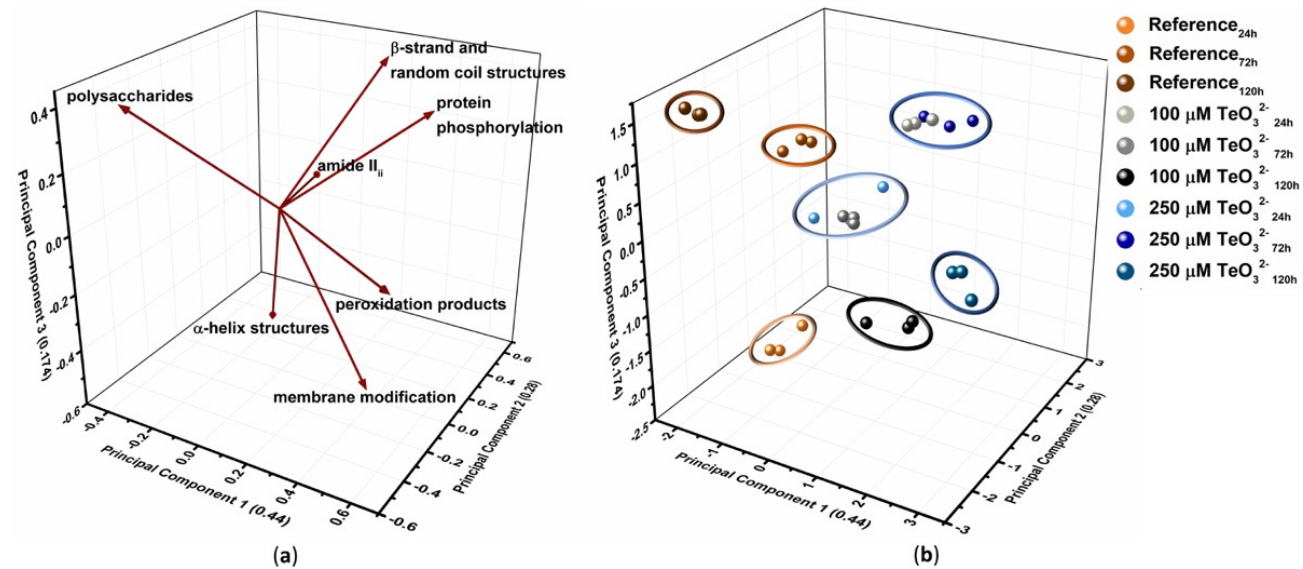
Figure 7. Representation of ( a ) loading and ( b ) score plots obtained by PCA performed on IR vibrational modes contributing the most to sample variability. Clusters identified by PCA are highlighted in ( b ) by colored circles.